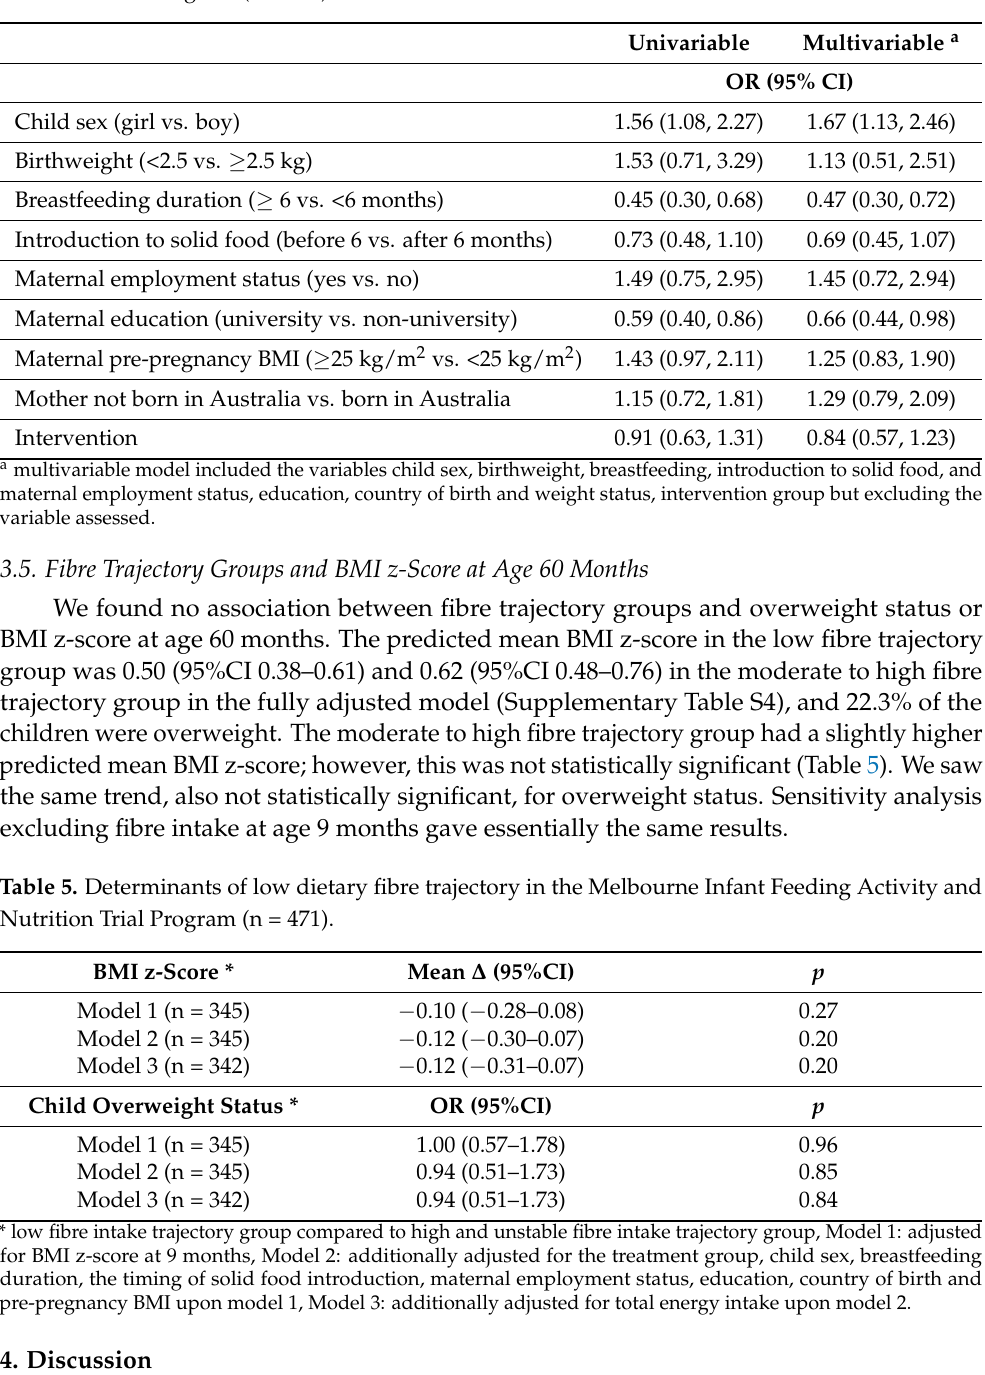
Table 4. Determinants of low dietary fibre trajectory in the Melbourne Infant Feeding Activity and Nutrition Trial Program (n = 471).